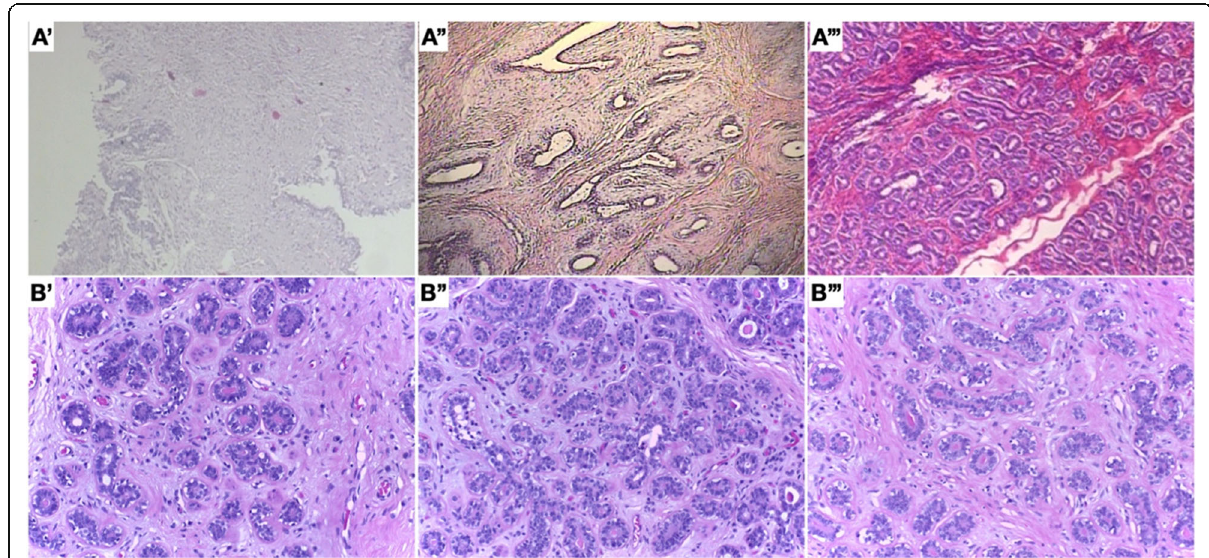
Box count fractal dimension analysis